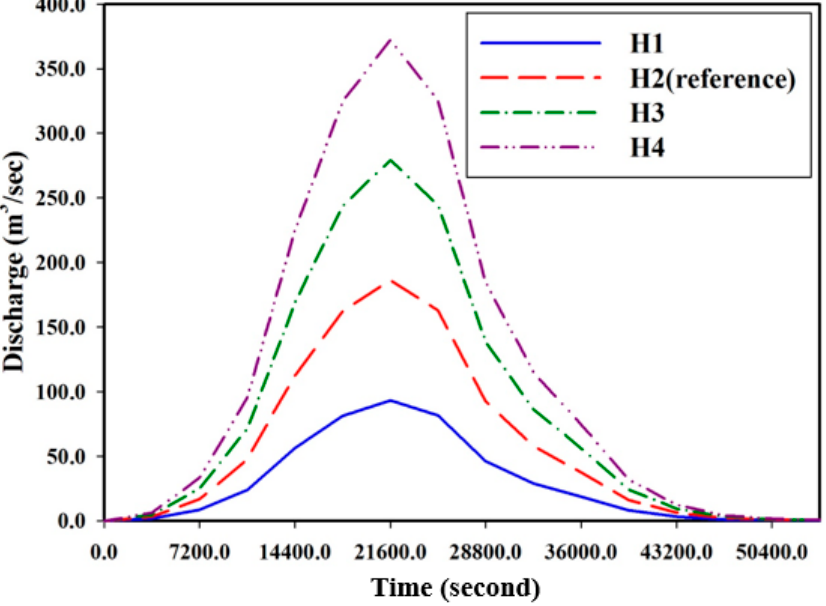
Figure 11. Flood hydrographs for the four